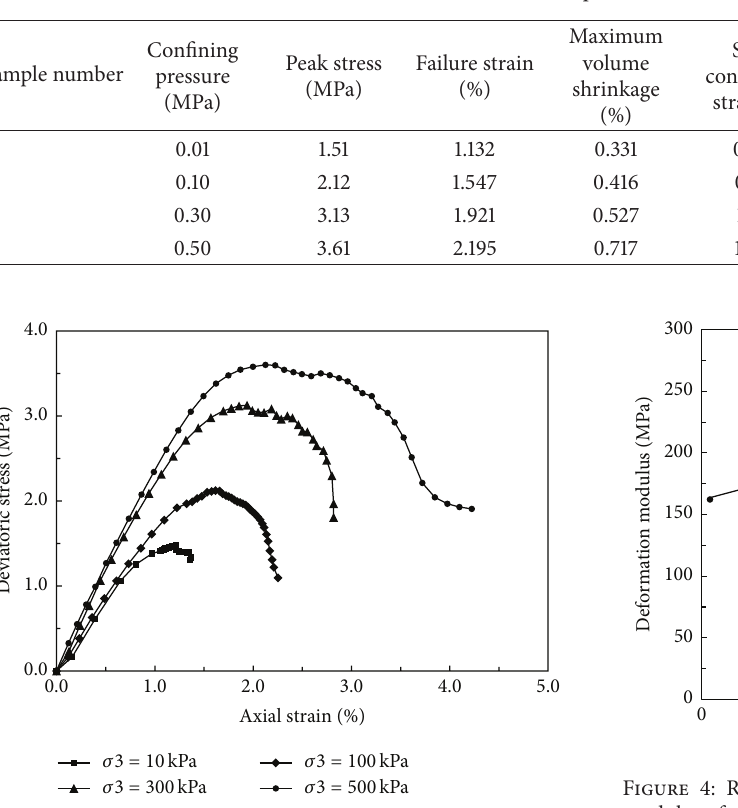
Table 1: Triaxial compression tests and results.